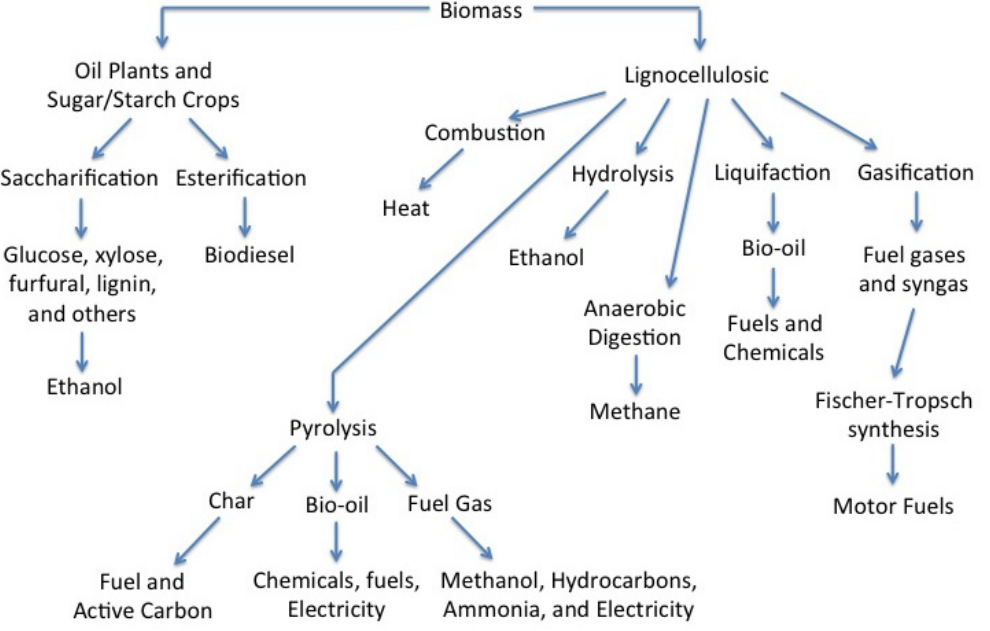
Figure 1. Schematic of biomass conversion